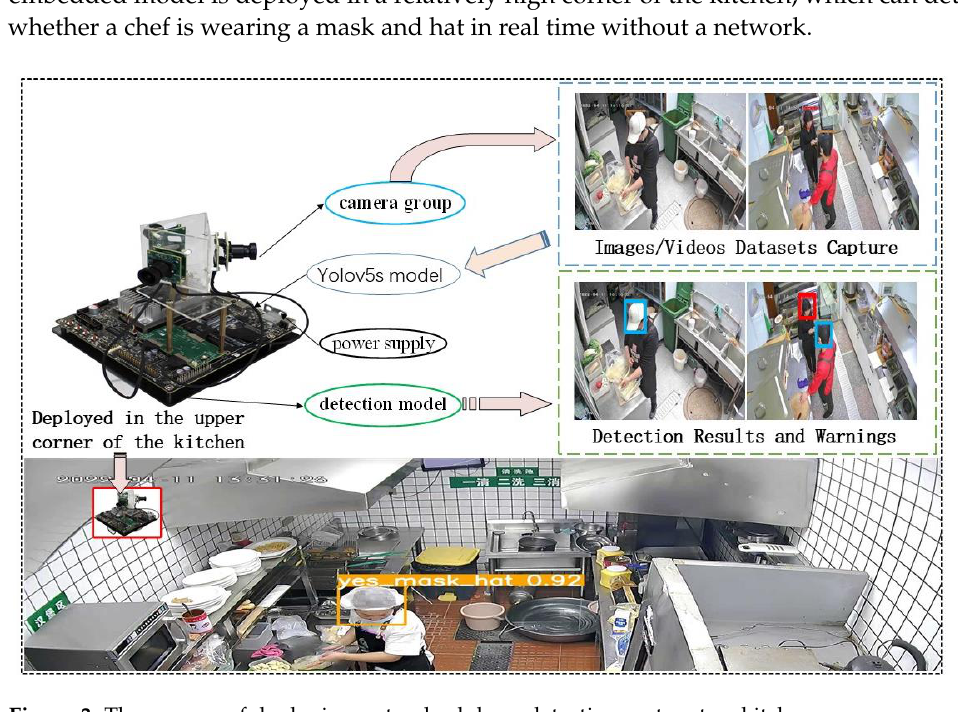
Figure 2. The process of deploying a detection model to Jetson Xavier NX.